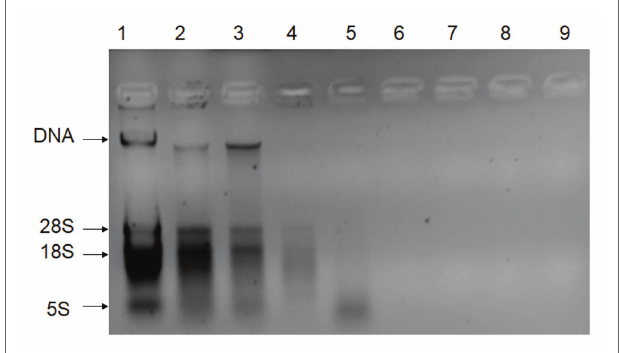
FIGURE 1 | Gel imaging analysis of all DNA extractions (without the digestion of RNA). Lane 1: DNA extracted from leaves; Lane 2: DNA extracted from stems; Lane 3: DNA extracted from fibers; Lane 4: DNA extracted from juices; Lane 5: DNA extracted from filter mud; Lane 6: DNA extracted from the syrup; Lane 7: DNA extracted from molasses; Lane 8: DNA extracted from the GM sugar; Lane 9: DNA extracted from the non-GM